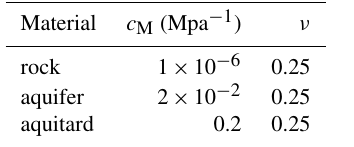
Table 1. Mechanical parameters.